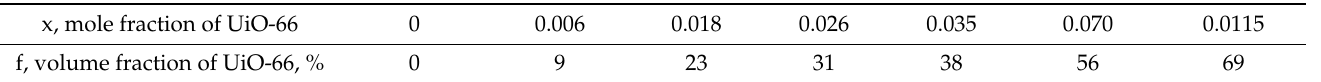
Figure 9. The isotherms of conductivity for CsH 2 PO 4 -UiO-66 as a function of the volume ( a ) and mole ( b ) fraction of UiO-66.